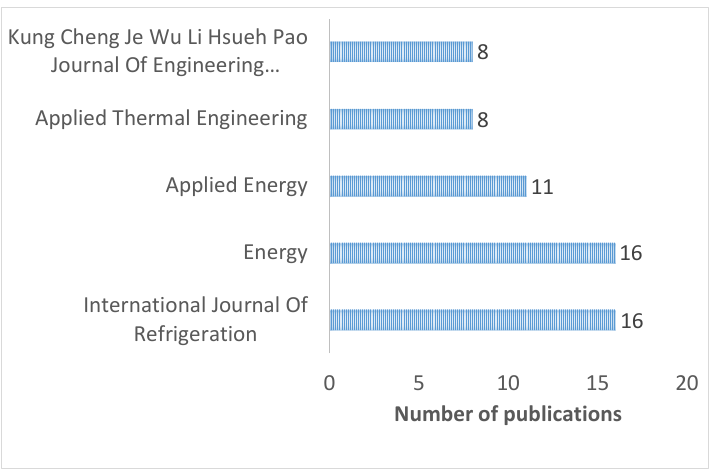
Figure 3. Type of documents published.